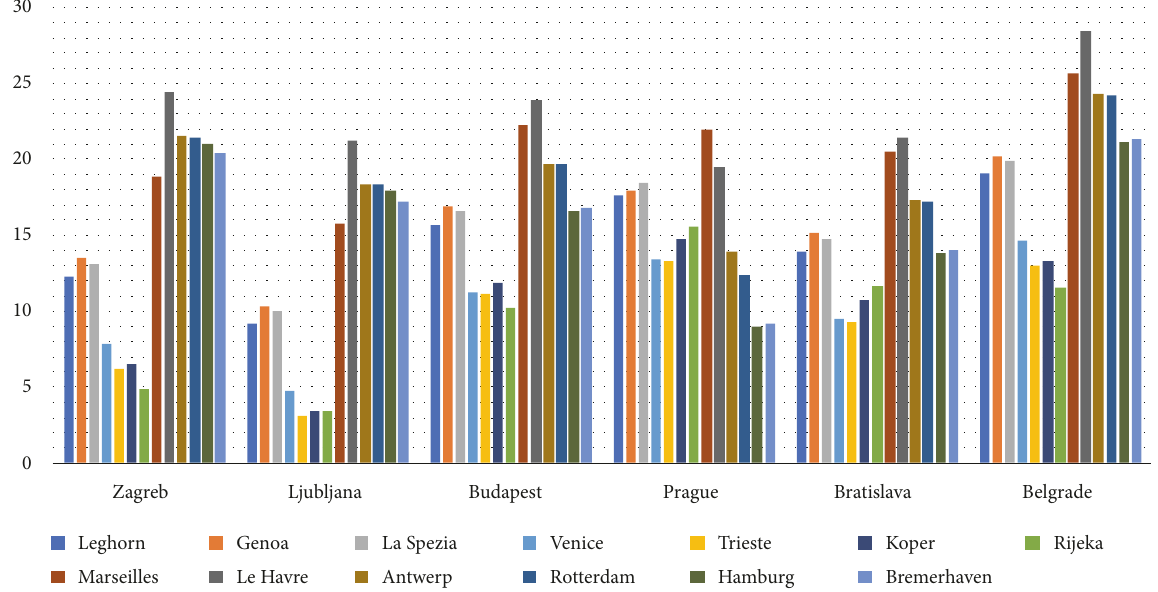
Figure 9: Travel times (h) from the ports considered in the analysis, towards Central-Eastern European destinations. Optimisation by travel times.